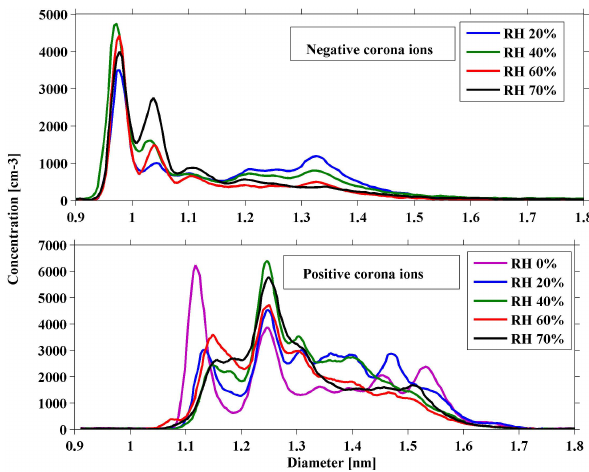
Fig. 5. Median size distributions of negative and positive ions gen- erated by the corona discharge as a function of relative humidity (RH). The corona voltage was ±